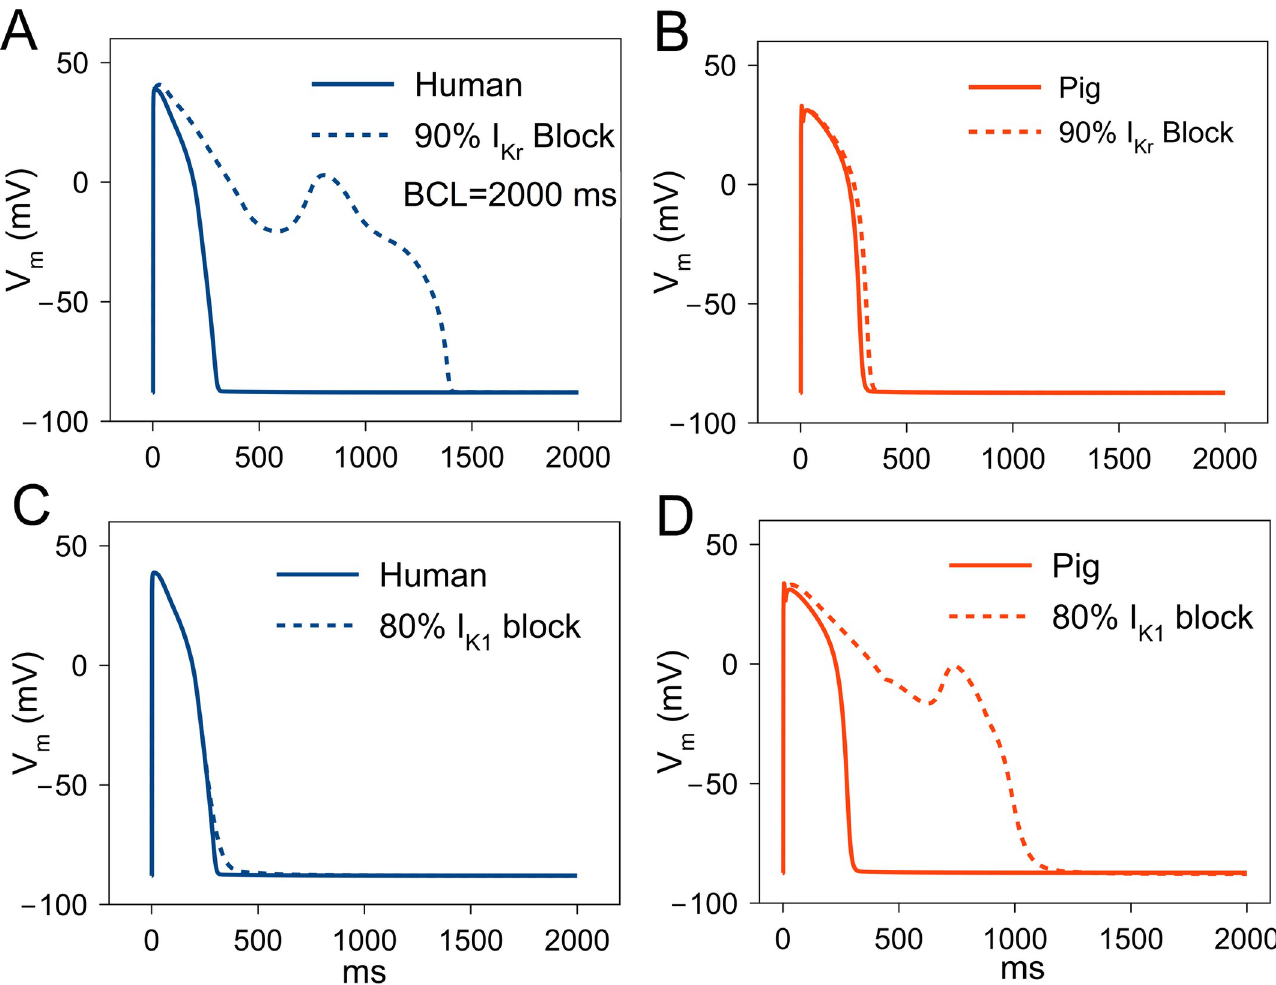
Fig 6. Early afterdepolarization (EAD) formation in human and pig ventricular myocyte. (A) 90% block of rapid delayed rectifier K + current (I Kr ) leads to EADs in human at a cycle length (CL) of 2000 ms. (B) Similar degree of block leads to small AP prolongation in pig. (C) 80% block of I K1 leads to EADs in pig (D) but not in